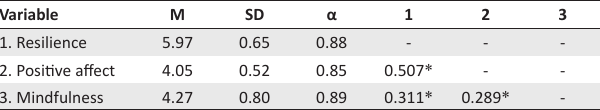
TABLE 2: Descriptive statistics and correlations amongst the variables. Variable